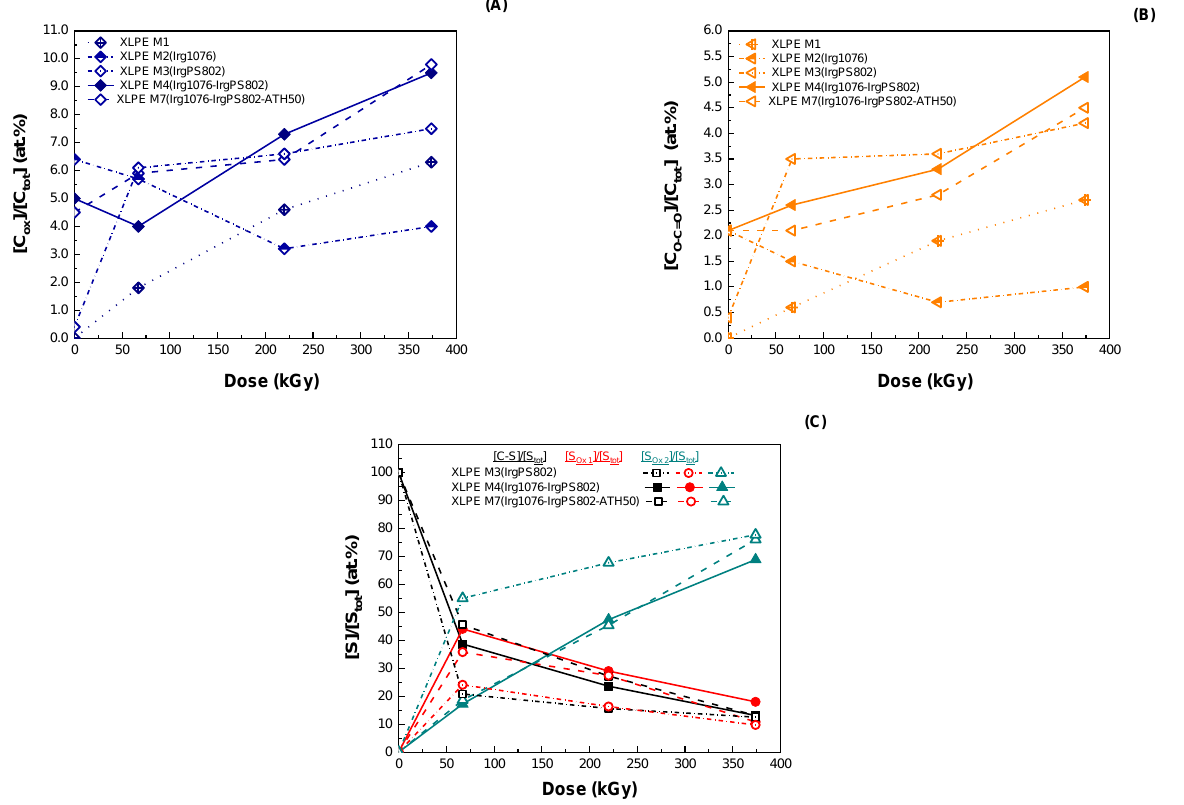
Figure 4. Evolution as a function of dose for XLPE M1, XLPE M2(Irg1076), XLPE M3(IrgPS802), XLPE M4(Irg1076-IrgPS802) and XLPE M7(Irg1076-IrgPS802-ATH50) of ( A ) C ox , which refers to all oxidised carbon atoms, (i.e., O- C =O, C -O and C =O) and of ( B ) O- C =O. Evolution as a function of dose for XLPE M3(IrgPS802), XLPE M4(Irg1076-IrgPS802) and XLPE M7(Irg1076-IrgPS802-ATH50) of ( C ) the different sulphur compounds (S ox1 refers to S =O and S ox2 refers to S O 2 and/or S O 3 ).